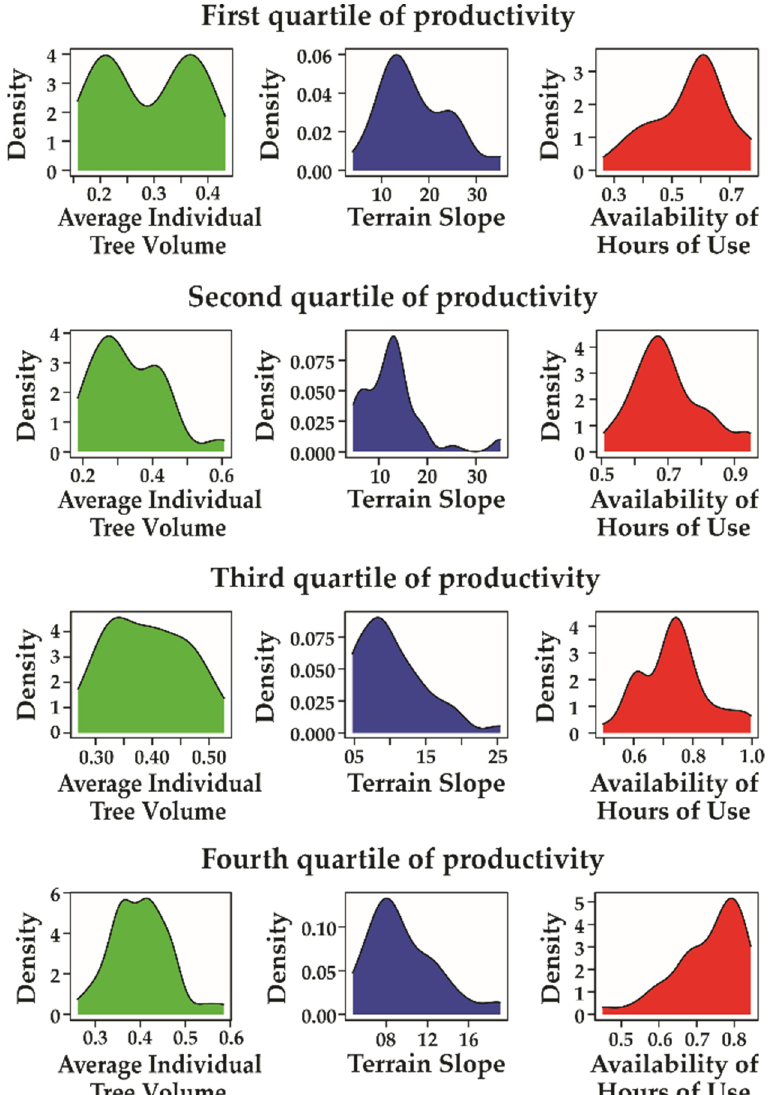
Figure 3. Density distribution of employed models.